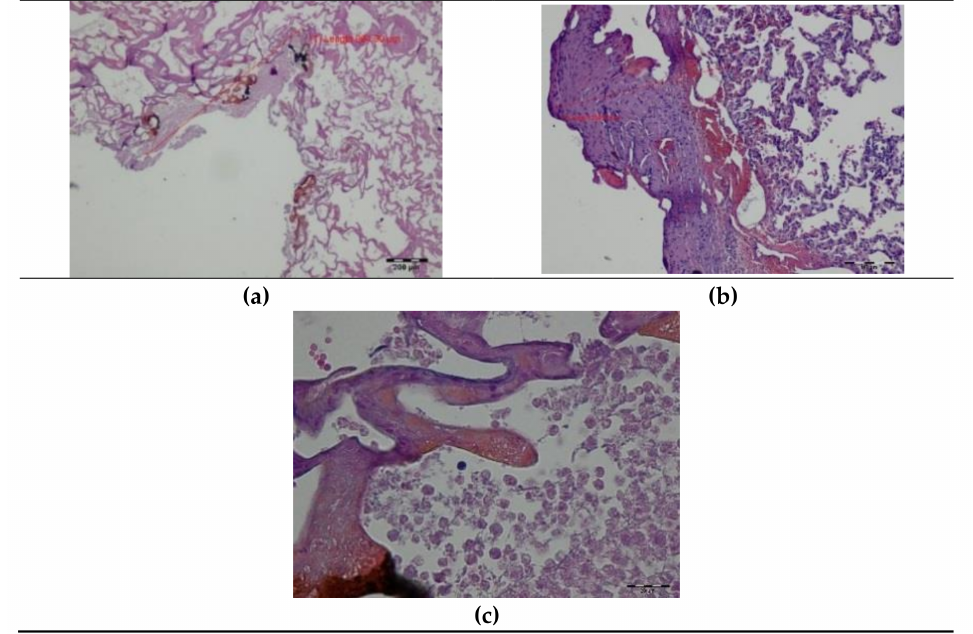
Figure 3. Histopathology of the pig lung tissue fragments after diode laser (DL) cutting on day 0: ( a ) total width of the thermal damage zone, magnification 40 × ; ( b ) superficial zone of thermal damage, magnification 100 × ; ( c ) superficial zone of thermal damage, magnification 400 × , HE